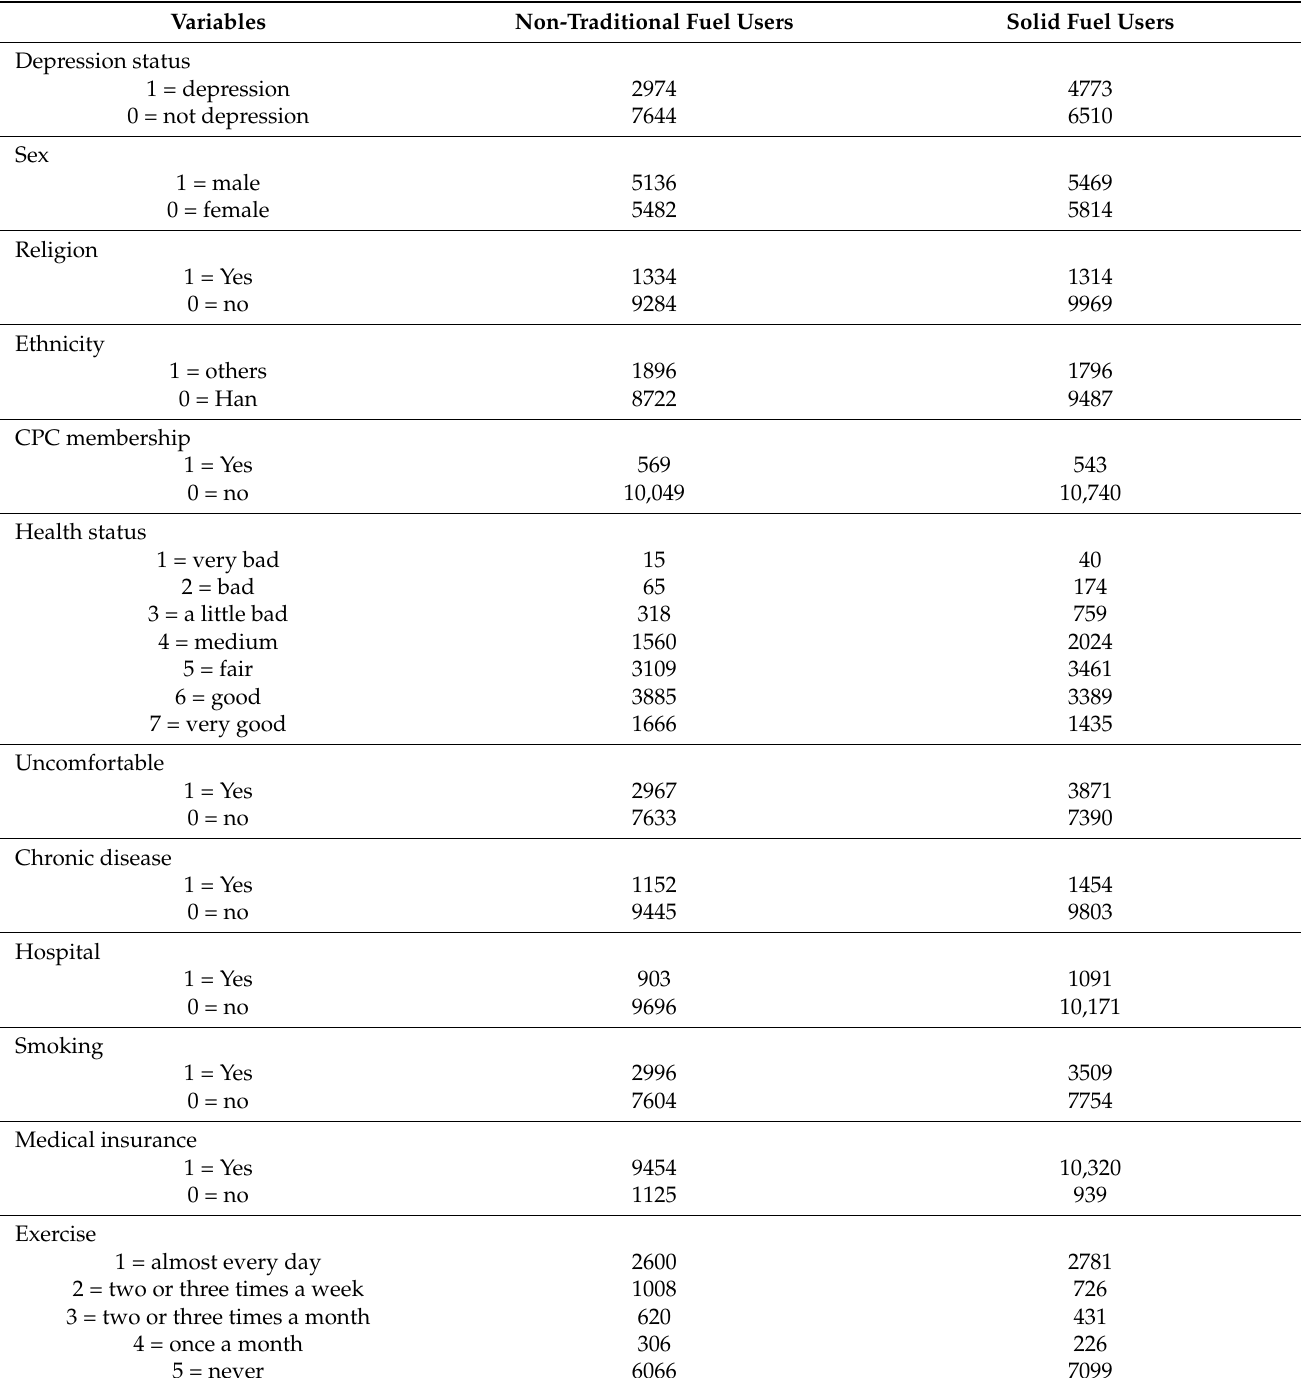
Table A2. The frequencies of binary variables for solid fuel users and non-traditional fuel